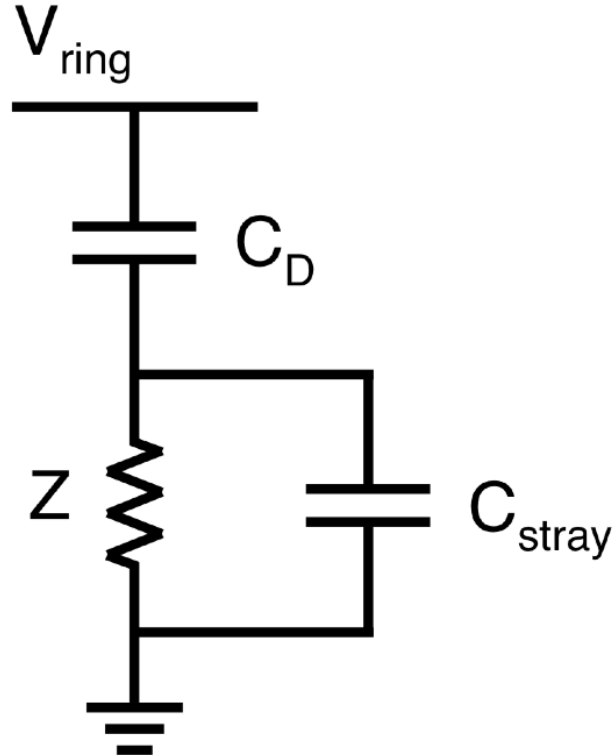
FIG. 10. Lumped-circuit model of an insulator-stack D -dot sensor